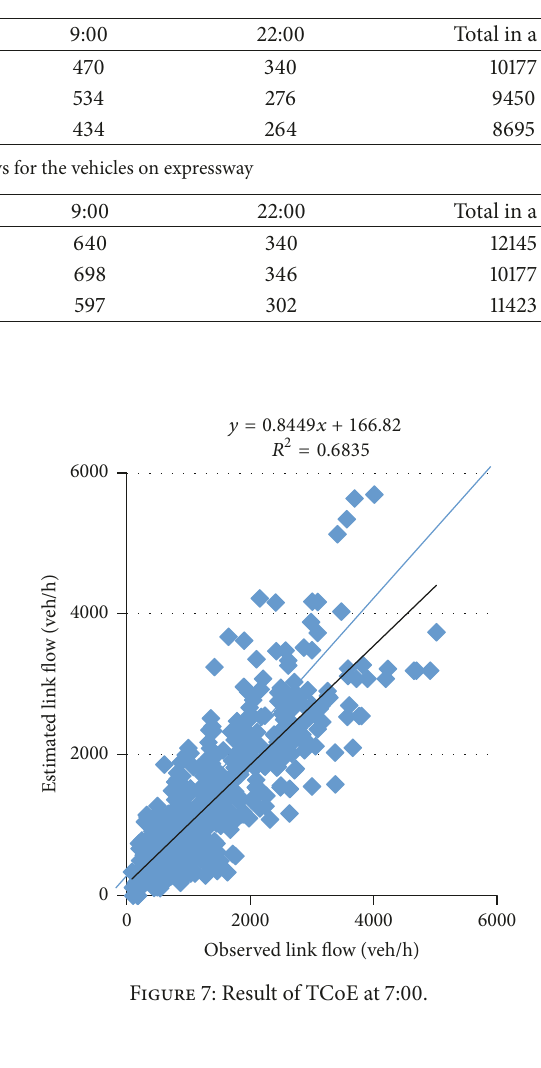
(a) Comparison of RMS error for link flows for all vehicles